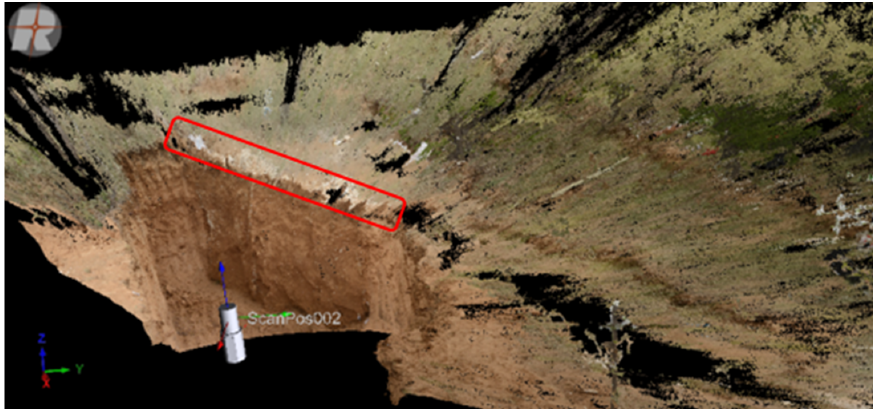
Figure 7. The original point cloud data in the western part of the ground fissure.